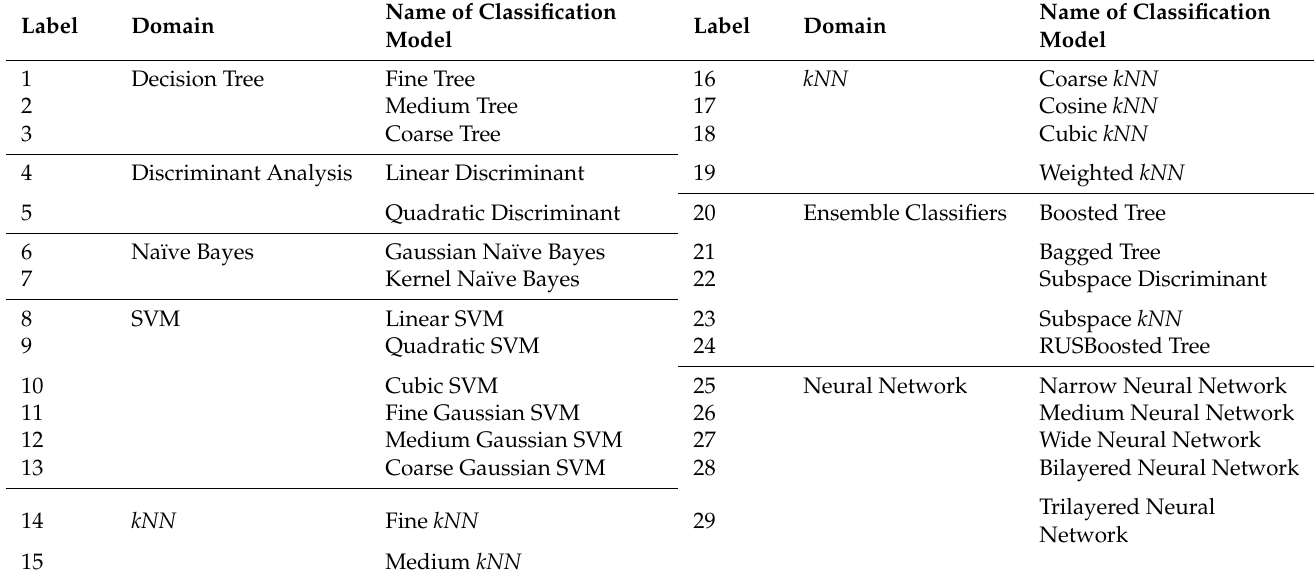
Table 2. Label for classification models.